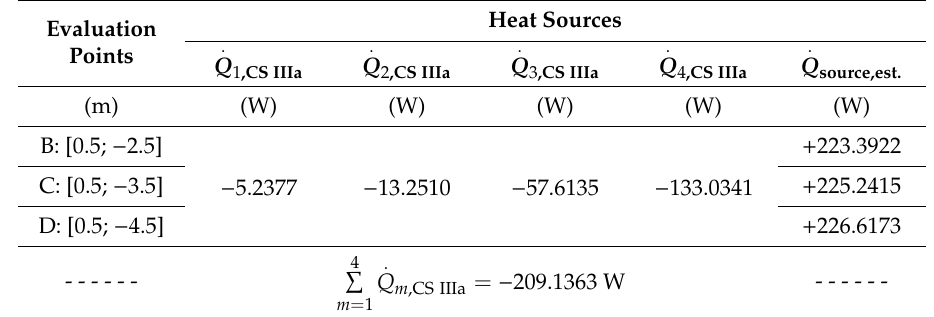
Table 10. Case study IIIa: 110% of the reference values of the negative heat sources 𝑄(cid:4662) (cid:2870),(cid:2887)(cid:2903) (cid:2893)(cid:2893)(cid:2893)(cid:2911) and 𝑄(cid:4662) (cid:2871),(cid:2887)(cid:2903) (cid:2893)(cid:2893)(cid:2893)(cid:2911) and the nominal values of the heat sources and D.